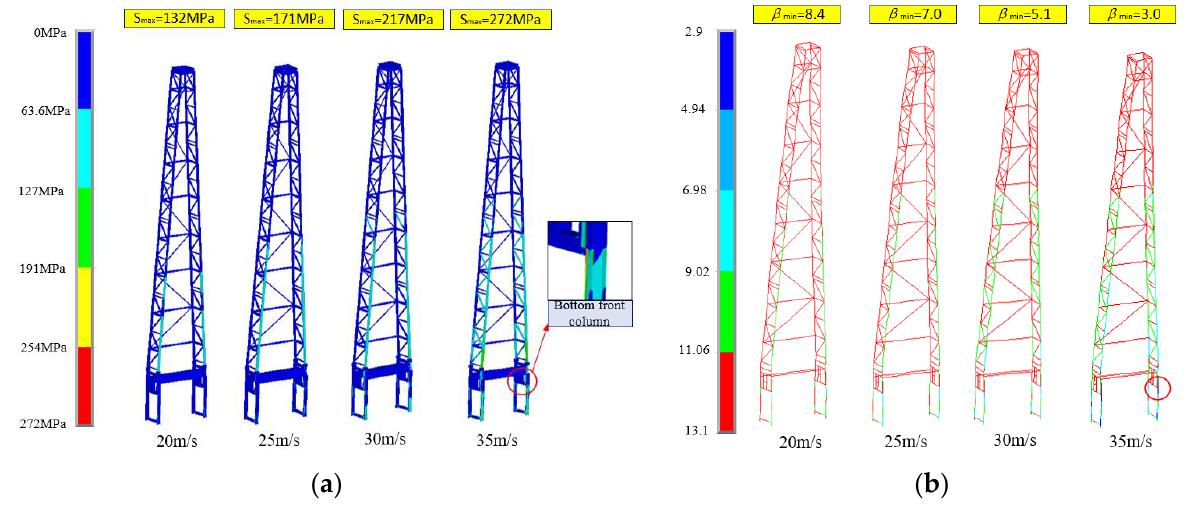
Figure 9. The variation of the stress and reliability index with increasing wind speed. ( a ) Stress contour plot. ( b ) Reliability index contour plot.